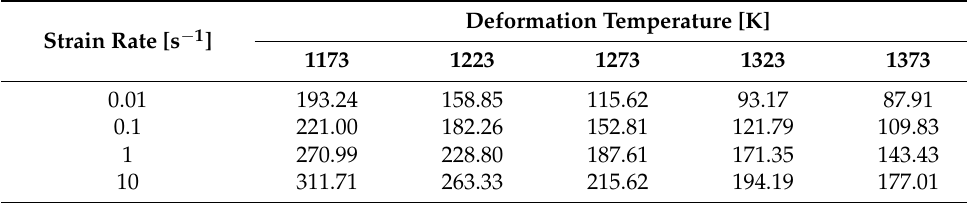
Deformation Temperature